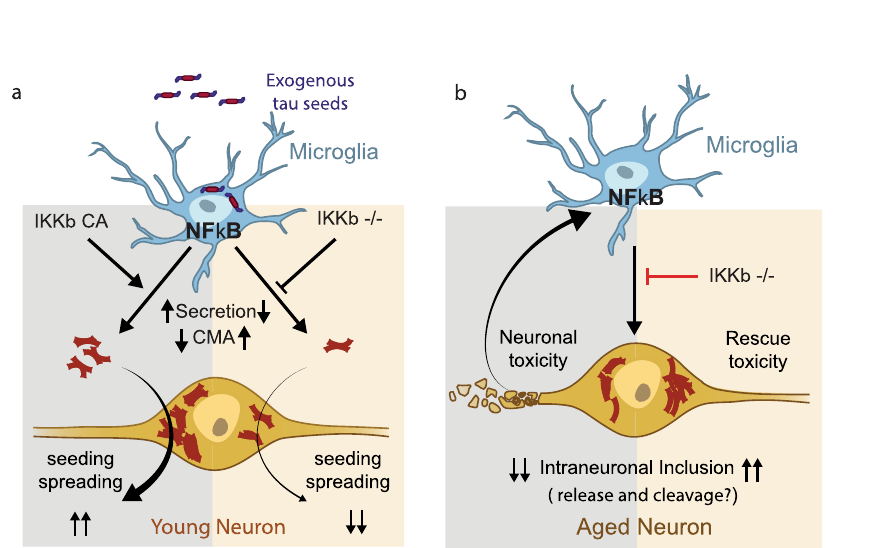
Fig. 7 NF- κ B is required to induce tau-associated microglia states in PS19 mice. Single-nuclei RNA-seq were performed using cortical tissues from Ikbkb + / + ( n = 4), Ikbkb + / + ; P301S + ( n = 3), Ikbkb − / − ; P301S + ( n = 2), and Ikbkb CA ; P301S + ( n = 2) mice. a UMAP plots of all single nuclei and their annotated cell types. OPCs Oligodendrocyte progenitor cells. b Proportion of cell types for each genotype. c UMAP plot depicting different microglial cell subclusters. Each cell was color-coded based on their cluster af fi liation. d Proportion of cells in each microglial subcluster for each genotype. e Pseudotime-time trajectory demonstrating the shift of microglial state. f Pseudotime-time trajectory of microglia labeled with genotypes. The trajectory illustrates the shift of microglial transcriptome from Ikbkb − / − ; P301S + to Ikbkb CA ; P301S + mice. g Venn diagram comparing the number and overlap of upegulated DEGs in Cluster 3 vs Cluster 1, and Cluster 4 and 5 vs Cluster 1. h , i Selected GSEA hallmark and Gene Ontology pathways identi fi ed for downregulated microglia DEGs in Cluster 1 vs Cluster 3 ( h ) and upregulated microglia DEGs in Cluster 4 and 5 vs Cluster 1 ( i ). GOBP GO biological processes, GOCC GO cellular compartment, GOMF GO molecular function.